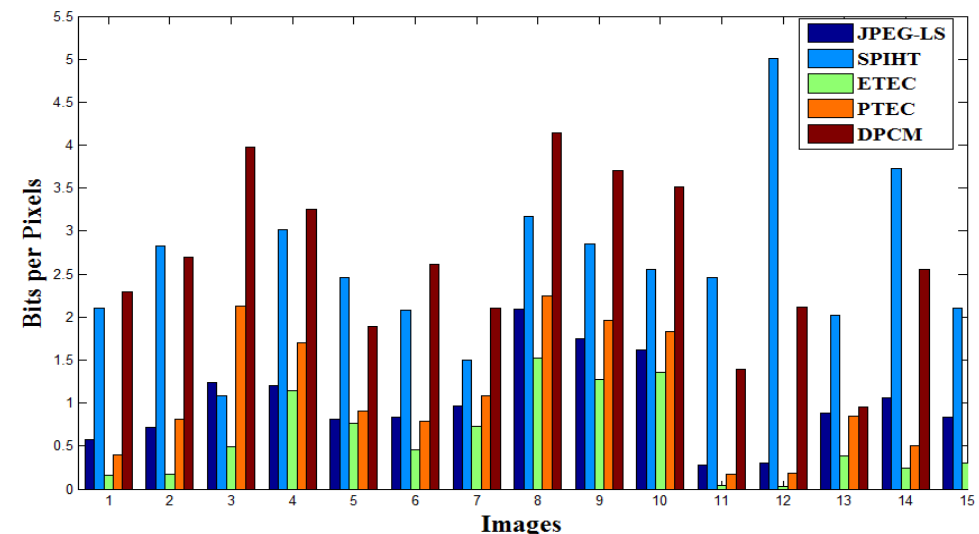
Figure 8. Comparison of bits per pixels for pixelated images.